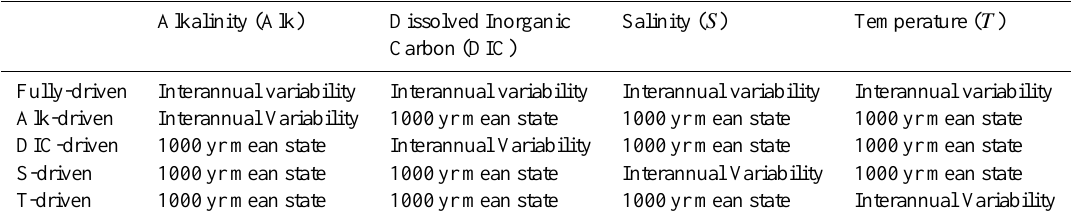
Table 1. Description of the distinct ocean carbon fluxes ( fg CO 2 ) or oceanic partial pressure of carbon ( p CO 2 ) driven by the variability of solely one driver (i.e., T/SST, S/SSS, DIC or Alk) compared to the fully-driven ocean carbon